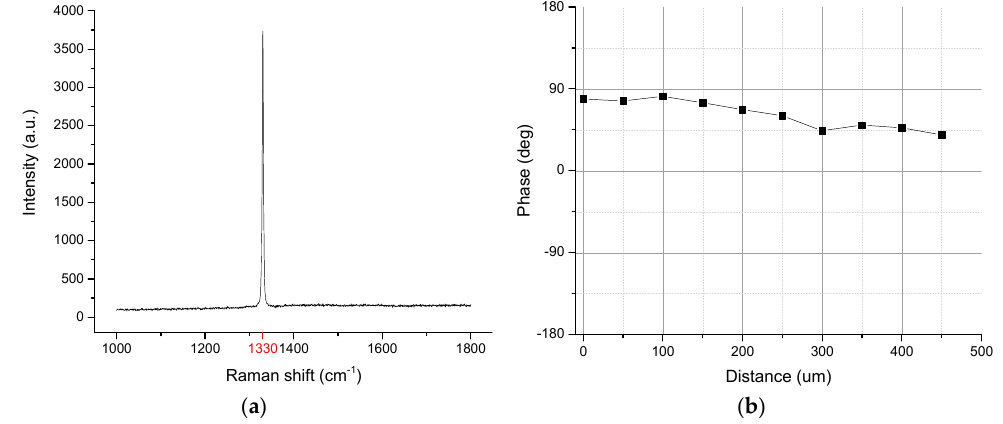
Figure 2. ( a ) Raman spectrum of the diamond film; ( b ) thermal diffusion coefficient of diamond film.